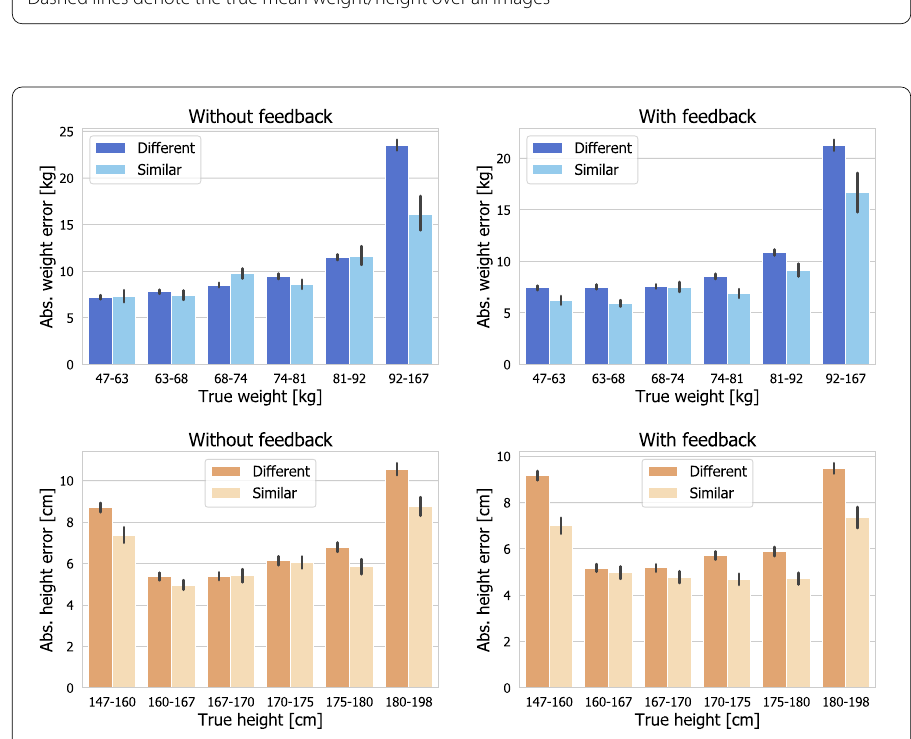
Figure 24 Mean absolute error of estimates in dependence on the previous image for the setups without feedback (left) and with feedback